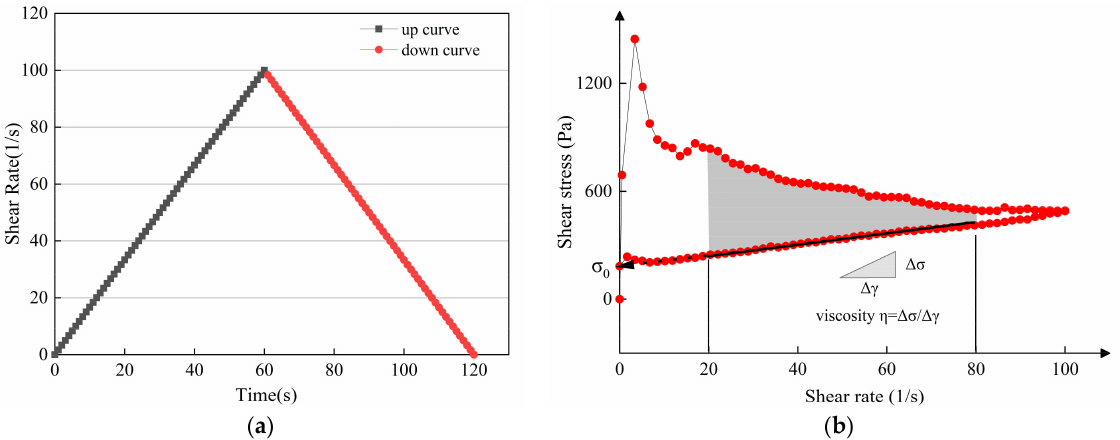
Figure 4. ( a ) The rheology test protocol and ( b ) the hysteresis loop obtained by the